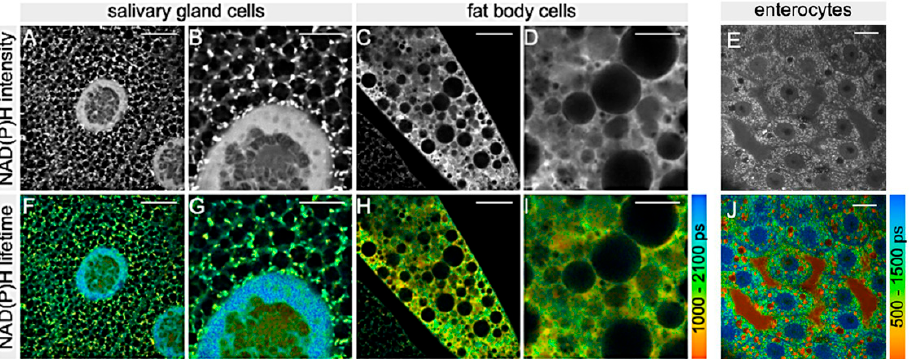
Figure 9. Fluorescence lifetime images recorded from salivary glands ( A , B , F , G ), fat body ( C , D , H , I ) and enterocytes ( E , J ) of D. melanogaster . Gray pictures represent the distribution intensity of the AF of NAD(P)H, and pseudo-color pictures represent the distribution of the mean lifetime values of NAD(P)H AF according to the respective color bars on the right; ps, picosecond. Bars = 10 μ m ( A , F , C , H , E , J ), 5 μ m ( B , G , D , I ). Modified from [102], with permission.